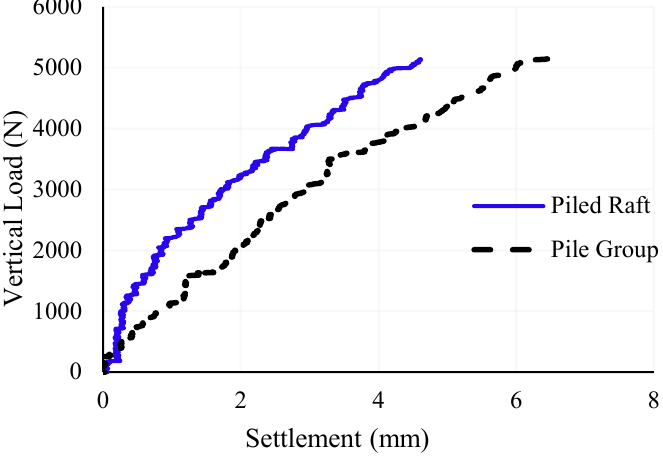
Figure 18. 17-pile group vs. 17-piled raft vertical response.